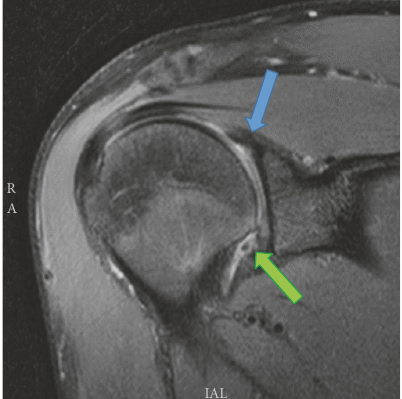
Figure 1: Coronal T2 weighted MRI demonstrating absence of the long head of the biceps tendon (blue arrow) and inferior labral tear (green arrow).